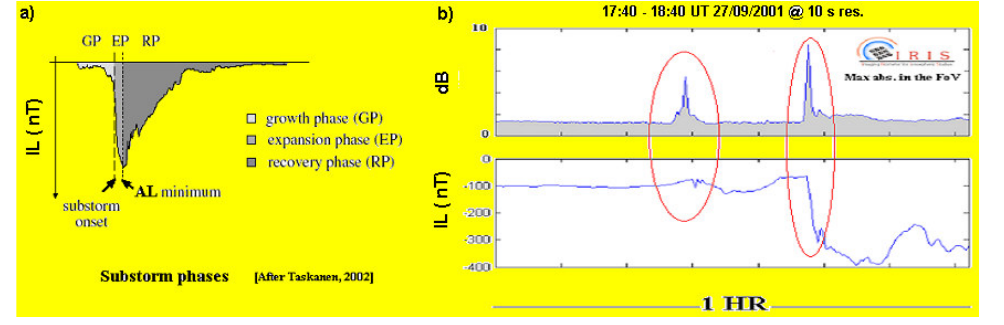
Fig. 12. (a) Phases of an ideal substorm is illustrated according to variation of IL index (After Taskanen, 2002). (b) Two spikes as signatures of pseudobreakup and substorm onset according to IL index variations. Event occurred in 27 September 2001 during 17:40–18:40 UT (20:25–21:25